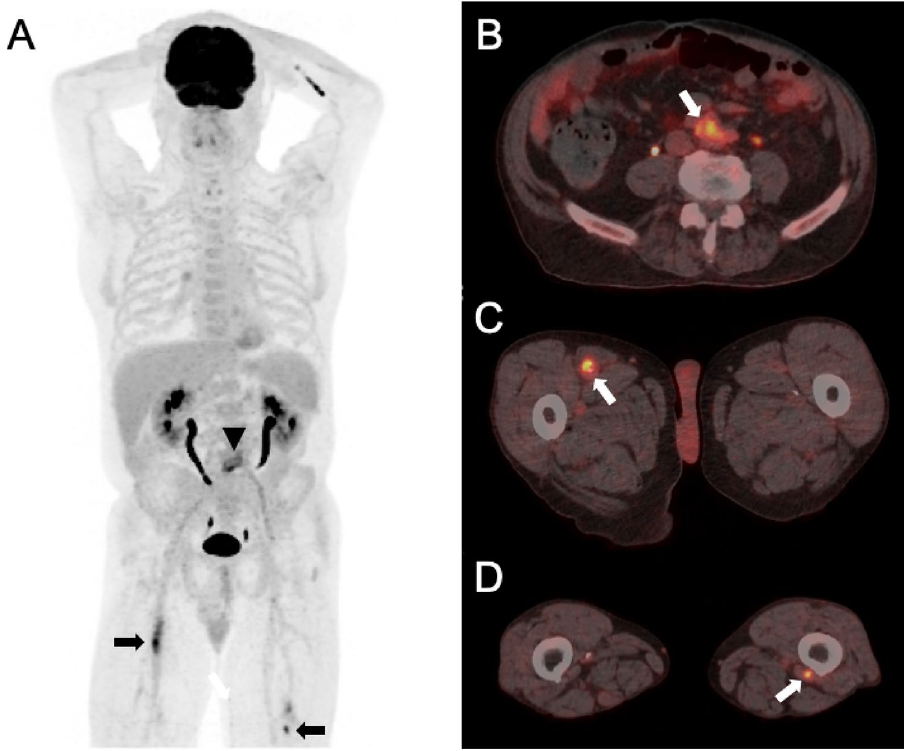
Figure 4. A 66-year old male patient was referred to PET/CT for follow-up of a vascular graft infection with P. aeruginosa . PET/CT [maximum intensity reconstructions of PET ( A ) and fused PET/CT images ( B – D )] showed intense focal FDG uptake of the aortobifemoral graft (black arrow head in A , white arrow in B ), suggestive for persistent infection. Subsequently, the aortobifemoral graft was reconstructed in situ with a SilverGuard Dacron graft. An unknown and potentially relevant incidental finding was detected in the upper thighs with intense focal FDG uptake, in line with septic emboli (black arrows in A , white arrow in C and D ). The incidental PET/ CT finding was rated not to have impact on patient management, since no direct action was initiated with regard to the potential septic emboli in the upper